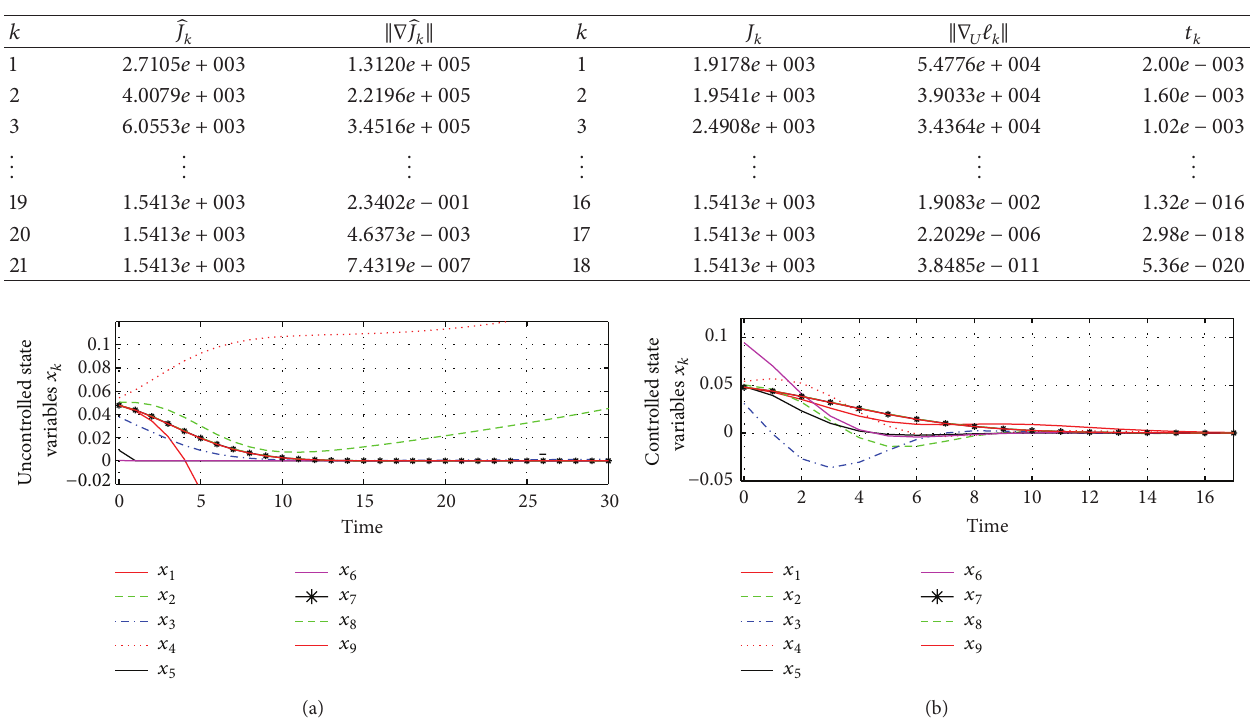
Table 2: Convergence behavior of the methods NM and DSQP for Example 17.